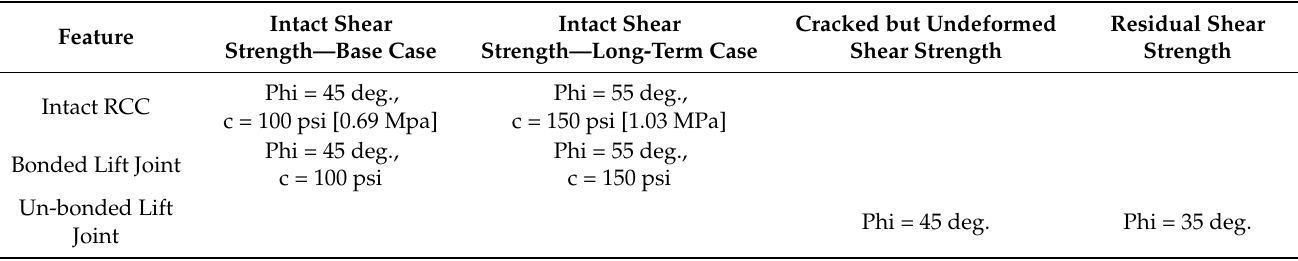
Table 6. Summary of estimated shear strength of RCC materials for structural analysis and evaluation of modeling results.